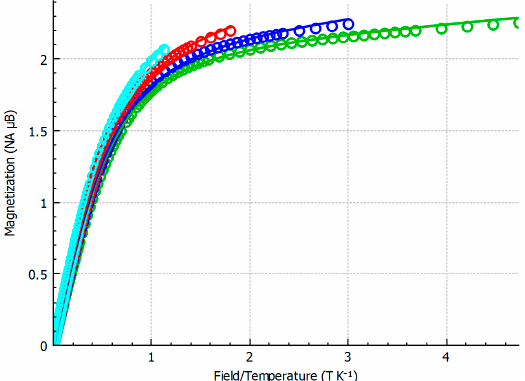
Figure 4. Isothermal reduced magnetization of compound 1 at 1.9 K (green), 3.0 K (dark blue), 5.0 K (red), and 8.0 K (cyan). Solid lines are the best-fit parameters to the model (see text).